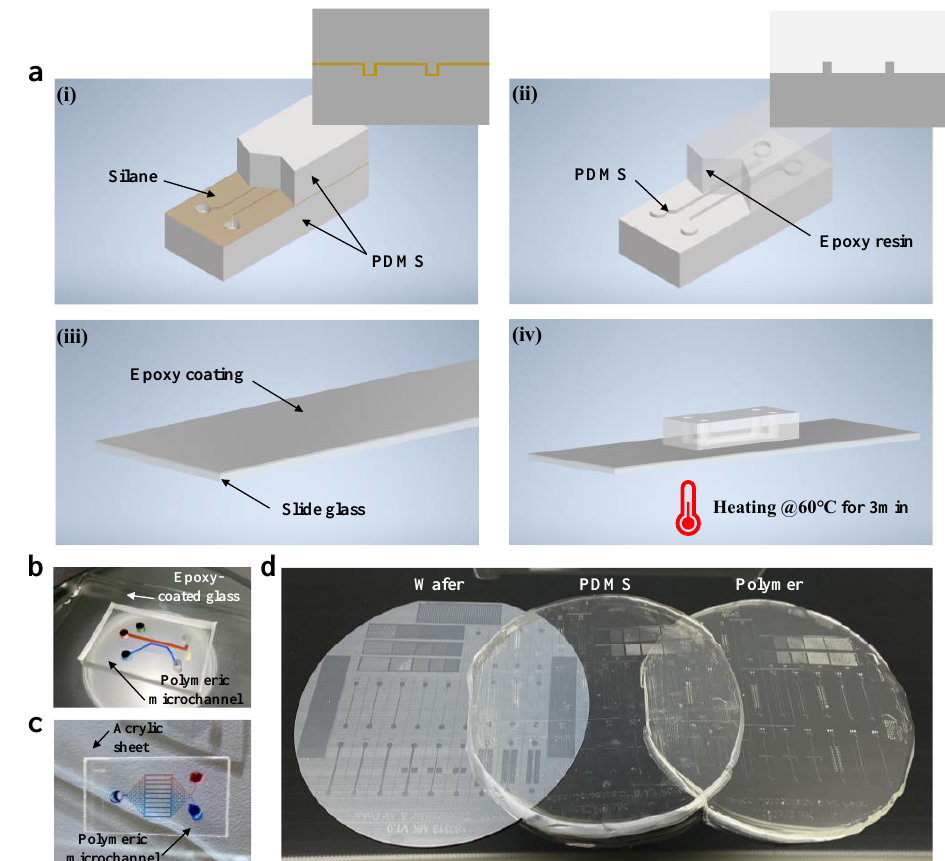
Figure 1. Illustration and photographs of fabrication process of epoxy-based microfluidic devices: ( a ) fabrication process of the polymeric devices. (i) Silane was coated on lower PDMS piece. PDMS was poured onto the lower piece to create a master mold for the polymeric devices, and cured at 60 °C for 2 h. (ii) The upper piece of (i) was peeled off and flipped over. Epoxy resin was poured onto PDMS and cured for 24 h at room temperature. (iii) Epoxy resin was poured onto a piece of glass and cured for 24 h at room temperature. (iv) Patterned epoxy was placed on the epoxy-coated glass and baked at 60 °C for 3 min on a hot plate. ( b ) Photograph of polymer-based microfluidic chip filled with dye. The device was fabricated via the abovementioned process. ( c ) Photograph of polymer device integrated with acrylic sheet. ( d ) From left to right: 6-inch wafer, PDMS, and polymer. For PDMS and polymer, wafer and PDMS were used as master molds, respectively.